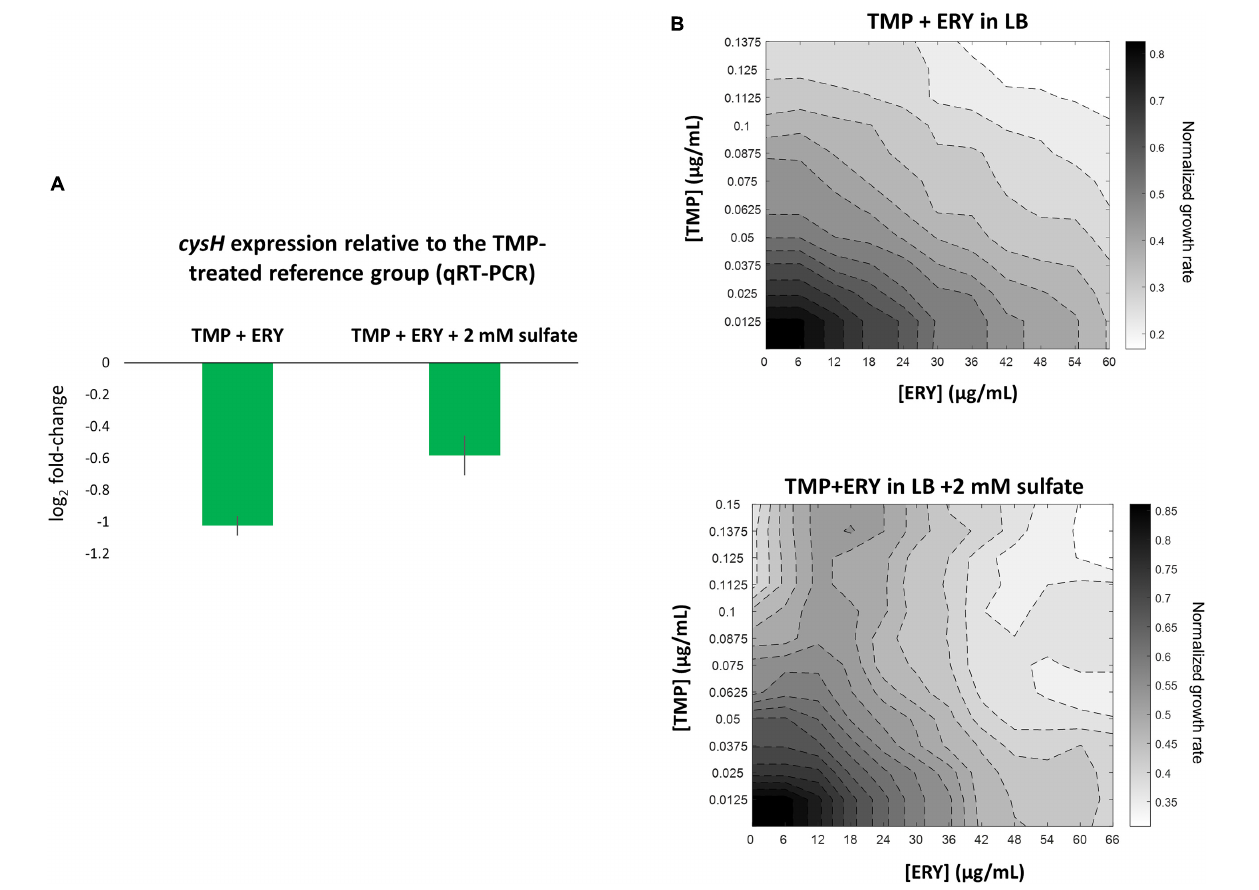
FIGURE 4 | Perturbing the sulfate reduction pathway by adding exogenous sulfate increases cysH expression level in TMP + ERY treated MG1655 and changes the TMP + ERY interaction from additive to suppressive. (A) qRT-PCR validation of cysH expression. Relative to the TMP-treated MG1655 reference group, the TMP + ERY treated group showed an approximately twofold reduction in cysH expression, which confirmed the role of ERY in suppressing cysH expression. Supplementing the LB growth medium in which the TMP + ERY treated group is grown with 2 mM sulfate caused an increase in average cysH relative expression. (B) ERY exerts suppression on TMP in growth medium supplemented with sulfate. Isoboles for TMP + ERY drug combinations when tested against the E. coli MG1655 strain. Supplementing LB medium with sodium sulfate at 2 mM changed the interaction between TMP and ERY from additive to suppressive. Suppression by ERY on TMP is stronger at higher concentrations of TMP in the presence of exogenous